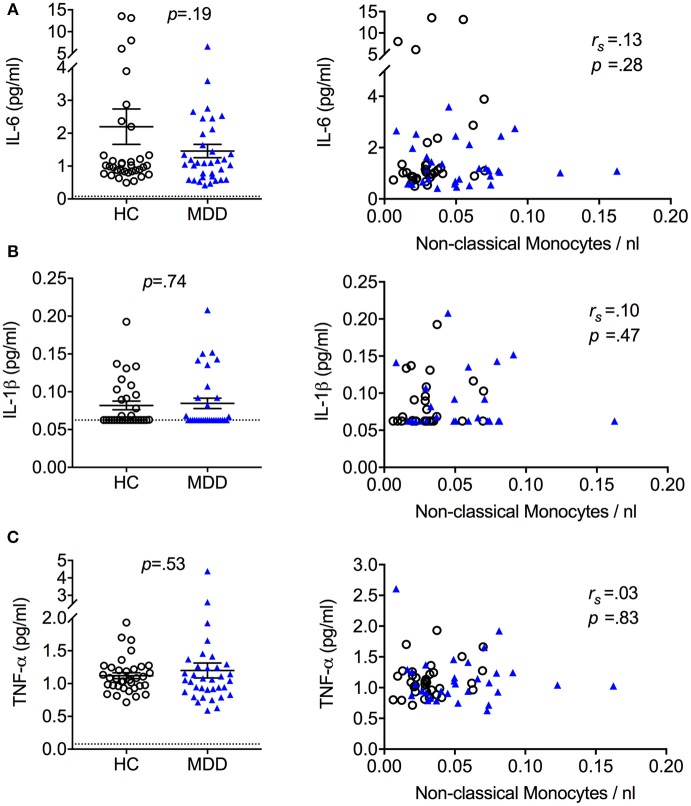
Serum cytokine levels in MDD patients and matched healthy controls (mean + S.E.M.). Serum cytokine levels of IL-6 (A), IL-1β (B), and TNF-α (C) quantified using a high sensitivity ELISA and association between serum cytokine levels and absolute cell counts of non-classical monocytes. Dotted lines represent the limit of detection 55% of IL-1β values from HC and 58% of IL-1β values from MDD patients were < 0.5 × limit of quantification (LOQ, dotted line) and thus set to 0.5 × LOQ. rs = Spearman's rho.